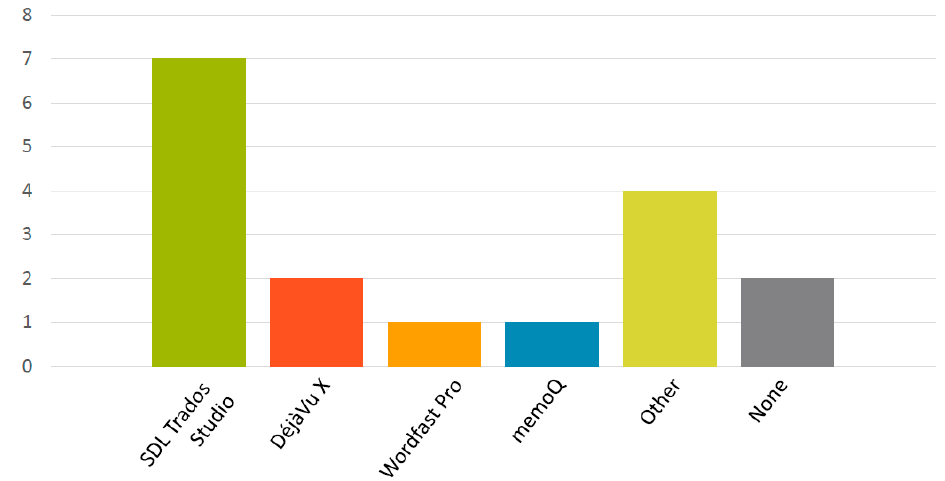
Figure 7. Participants’ demographics: familiarity with Computer-Assisted Translation (CAT) tools.